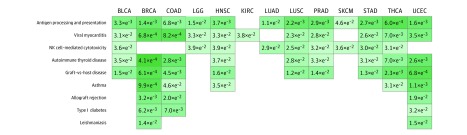
Heatmap Derived From Comparison of Individuals With No Cancer vs Patients With CancerThis heatmap shows the significantly enriched pathways derived from the significantly differential germline variants between individuals with no cancer and patients with 13 cancer types (eMethods 8 in the Supplement). Columns represent APP, NK cell pathways, and NK cell–associated phenotypes, and rows represent cancer types. BLCA indicates bladder cancer; BRCA, breast cancer; COAD, colon cancer; HNSC, head and neck squamous cell carcinoma; KIRC, renal cancer; LGG, glioma cancer; LUAD, lung adenocarcinoma; LUSC, lung squamous cell cancer; PRAD, prostate cancer; SKCM, skin cancer; STAD, stomach cancer; THCA, thyroid cancer; and UCEC, endometrial cancer.